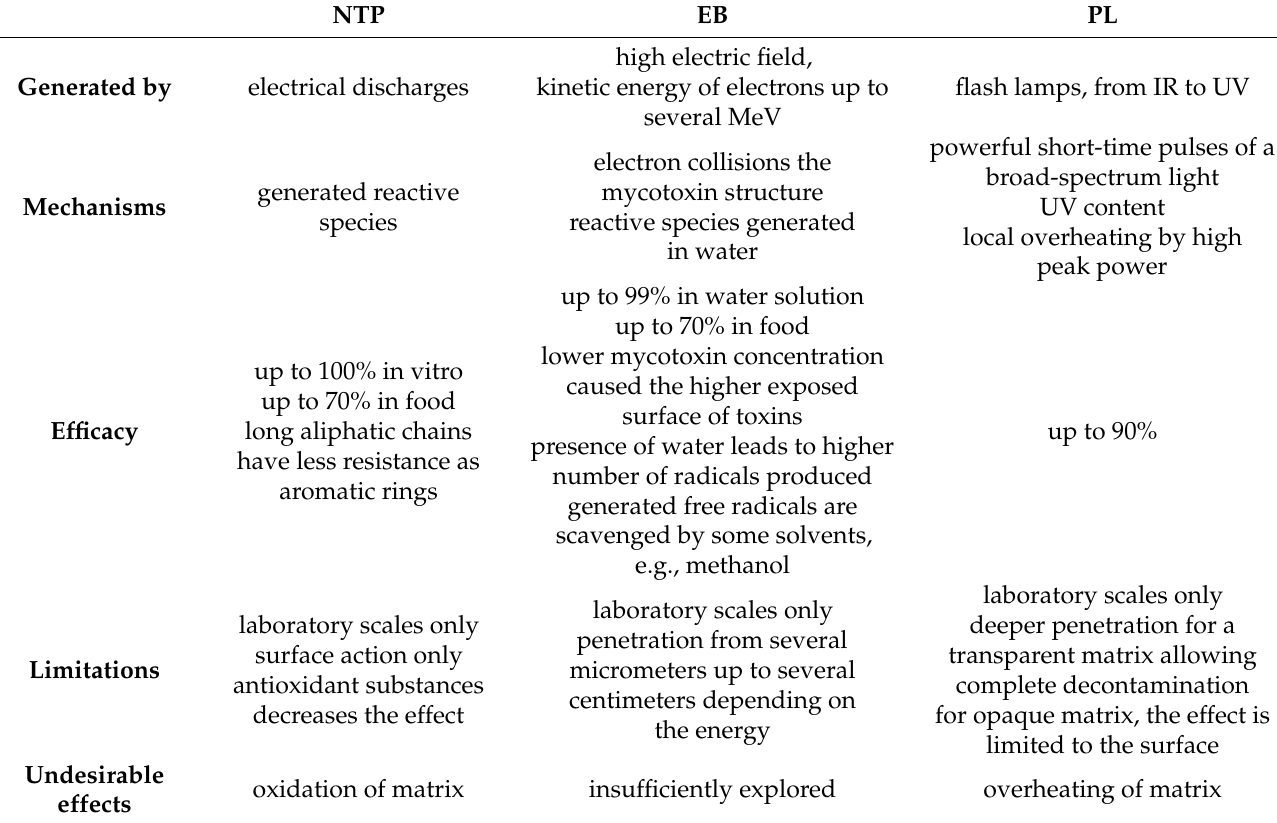
Table 2. Comparison of specific methods with the respect to efficacy, limitations, and undesirable effects. NTP EB